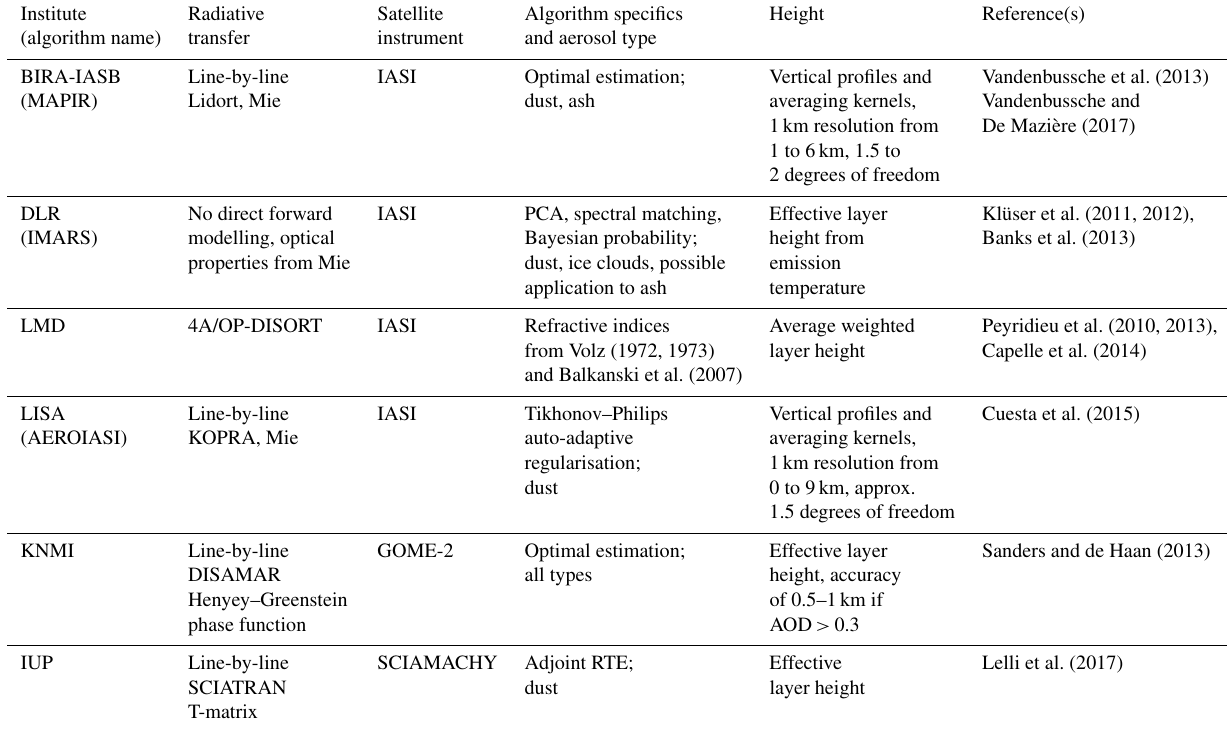
Table 1. Summary of dust height retrieval algorithms. See text for further details, including definitions of acronyms. Institute Radiative Satellite Algorithm specifics